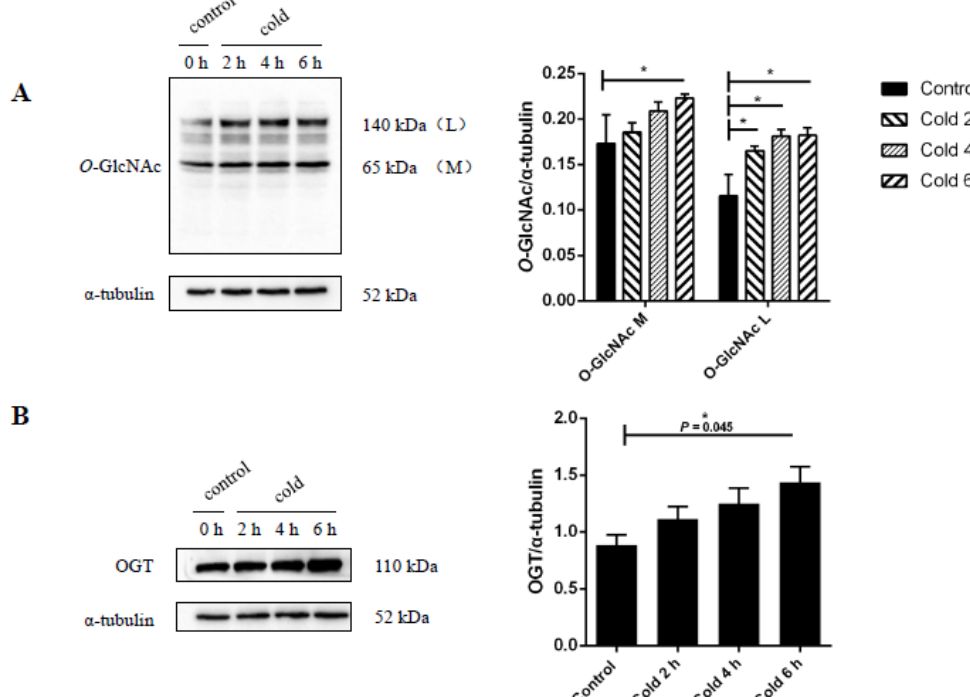
Figure 4. Effect of acute cold stress on the expression of global levels of O -linked β - N -acetylglucosamine ( O -GlcNAc) glycosylation and O -GlcNAc transferase (OGT) protein in the liver. ( A ) Global O -GlcNAcylation levels in liver and ( B ) levels of OGT. The data are presented as mean ± SEM ( n = 8). Statistically significant differences are indicated, * p < 0.05.